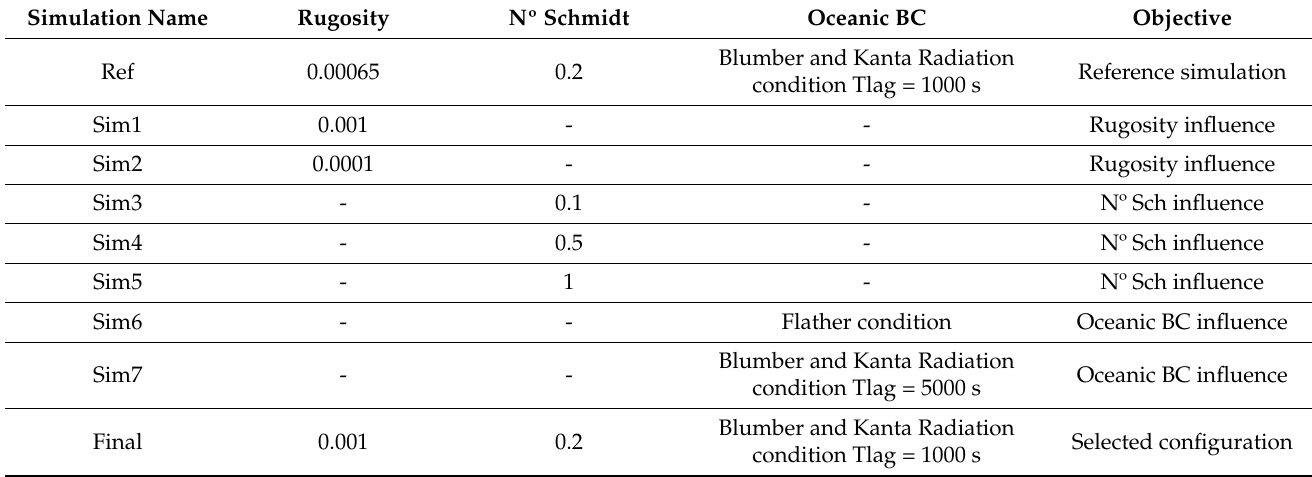
Table A1. RPtide model calibration test and range parameters. Ref is the reference simulation; for the other simulations, only the modified parameters are shown. The parameters for the selected configuration after the calibration process are referred to as Final.